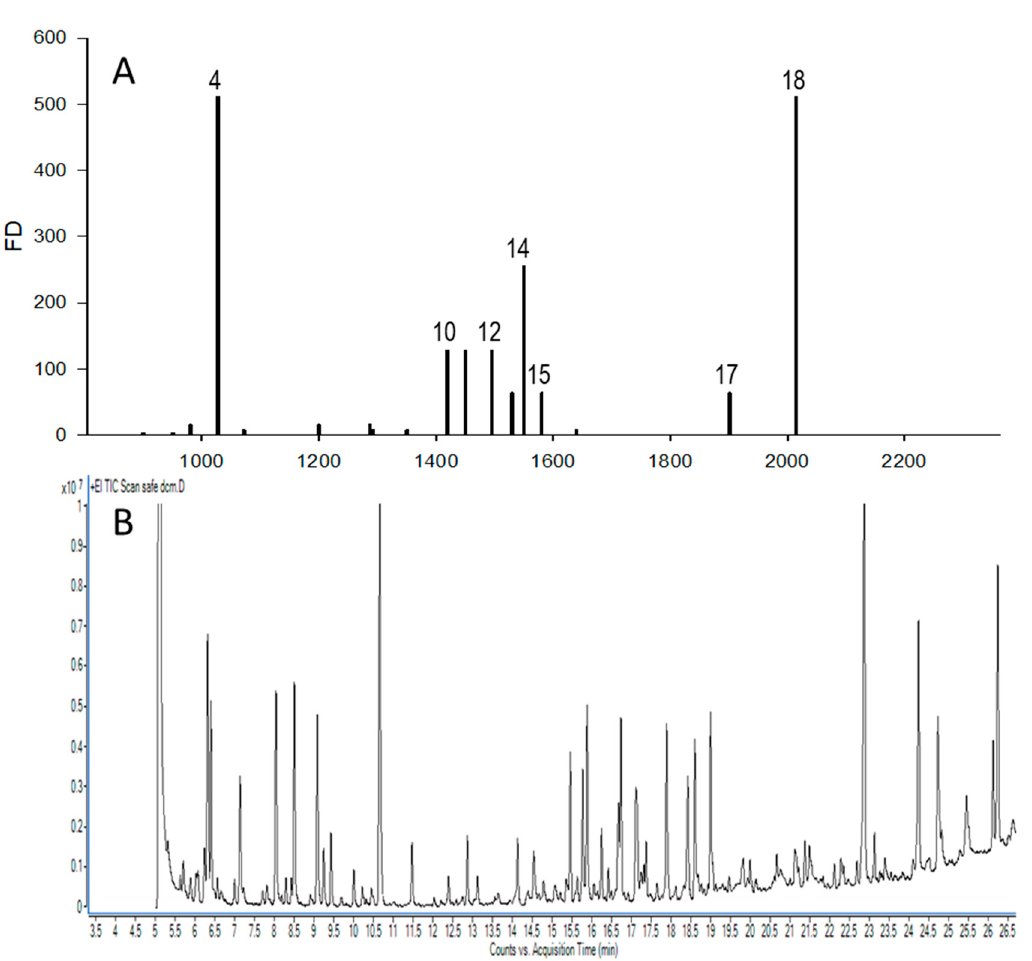
Figure 2. Compilation of aromagram ( A ) and TIC chromatogram ( B ) of odor active and volatile compounds in cape gooseberry fruit. Compounds number on ( A ) correspond to those in Table 1.